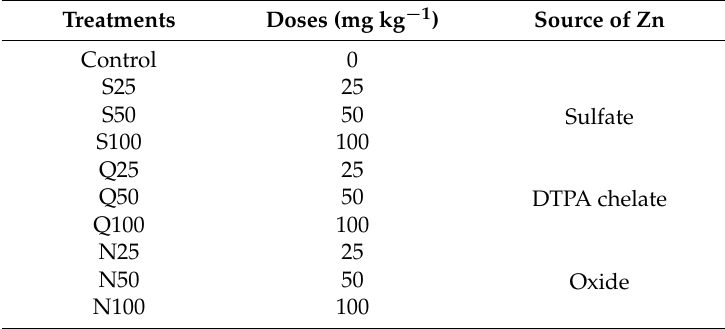
Table 1. Description of treatments (dosage and form of